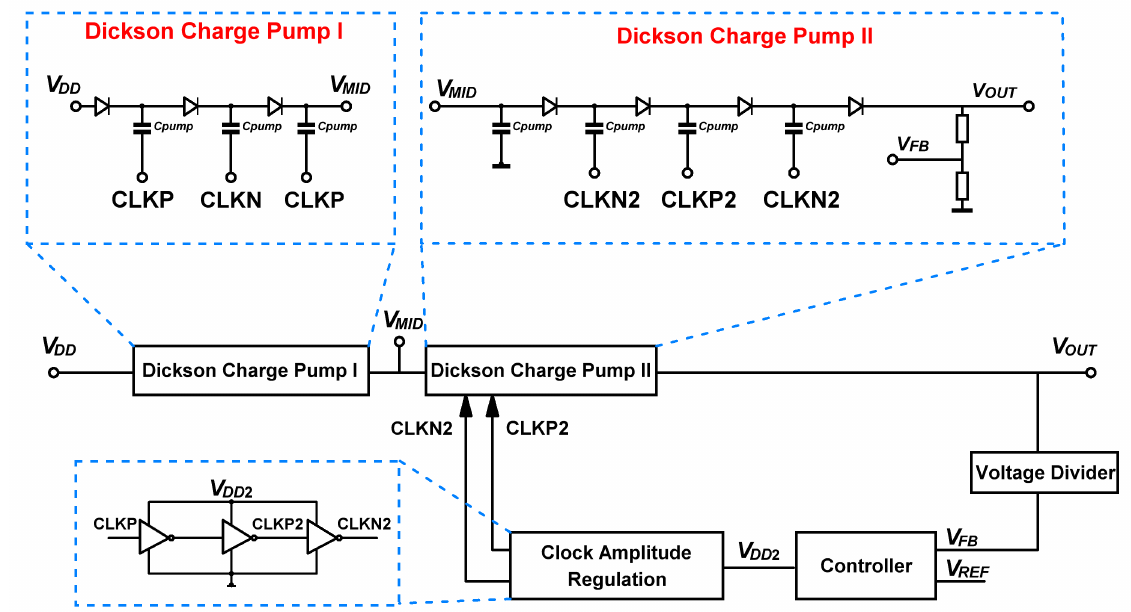
Figure 1. Block diagram of the proposed charge pump.